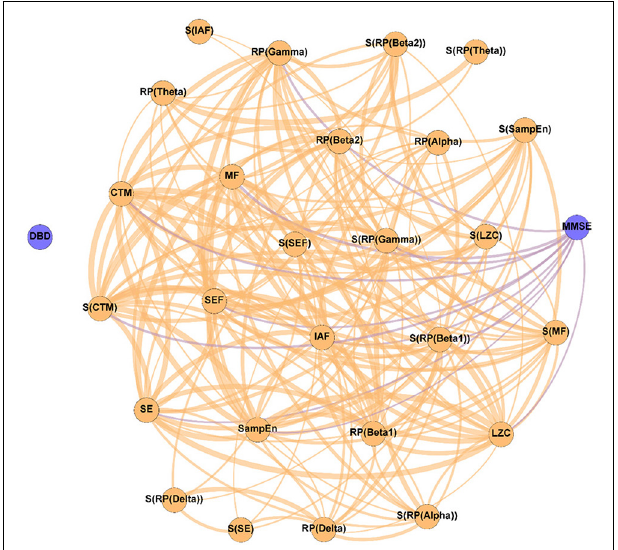
FIGURE 2 | Parameter network of the patients with Alzheimer’s disease (AD) before the NPT (Pre-NPT network). Wider edges correspond with stronger associations. Nodes corresponding to cognitive and behavioral parameters are shown in blue, while nodes of neurophysiological parameters are shown in orange.